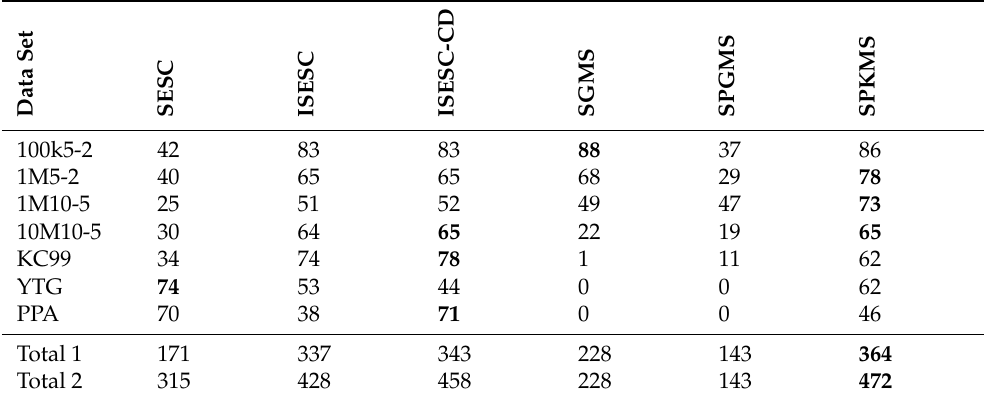
Table 4. ARI rank scores. The table shows in how many micro-batches the algorithm was the best, in terms of ARI, or statistically equivalent to the best. The bold cells highlight the best algorithm for each data